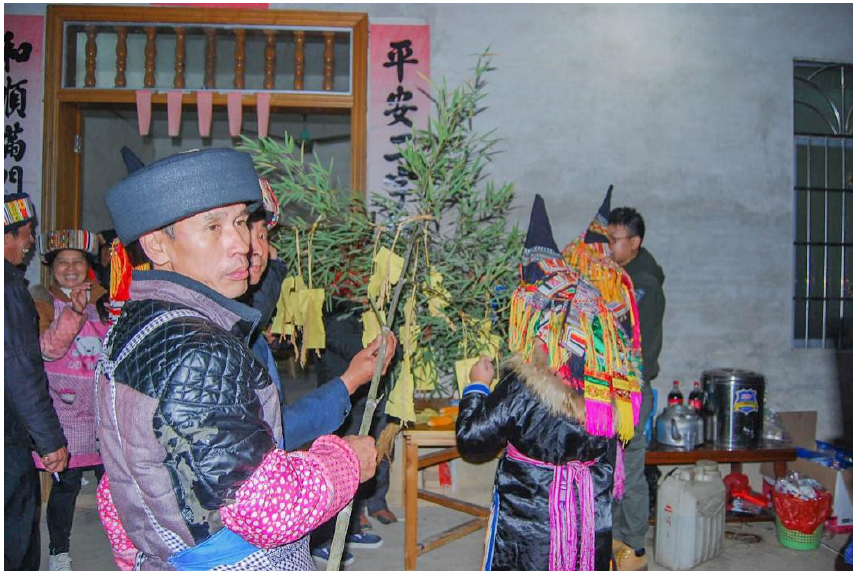
Figure 7. The masters making the steamer of five grains . C4, Enchanting grains (bian he, 變禾 ). At 6:30 p.m., master Zhao Wenfu stood next